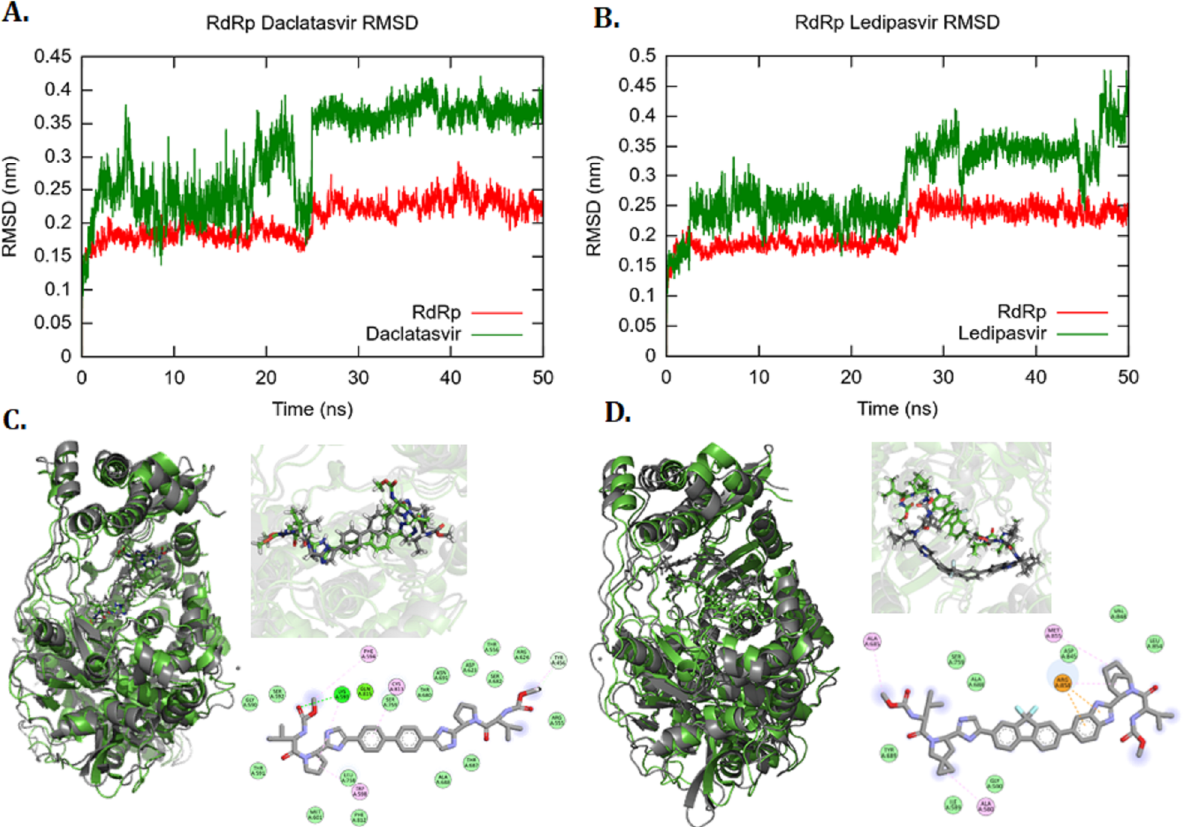
Figure 1. Molecular interaction analysis of simulated RdRp-ligand complexes RMSD plot of the ( A ) backbone of RdRP (Red) and DCV (Green) and ( B ) RdRp backbone (Red) and LDP (Green) for 50 ns MD simulations. Structural comparison and illustration of molecular interaction of ( C ) RdRp- DCV complex ( D ) RdRp-LDP complex, before and after 50 ns simulations. (RMSD: root mean square deviation; RdRp: RNA dependent RNA polymerase).